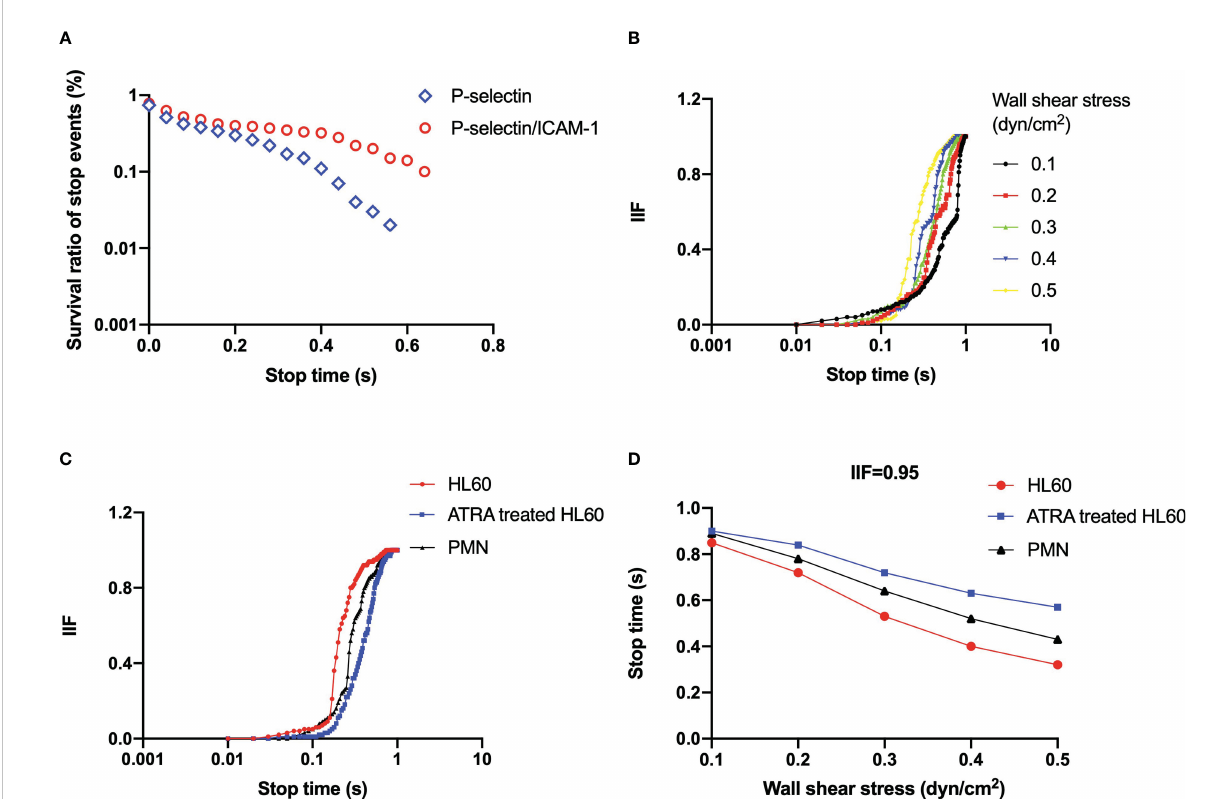
FIGURE 5 (A) Representative plot of the survival ratio of stop events versus stop time under wall shear stress of 0.3 dyne/cm 2 for all-trans retinoic acid (ATRA)- treated (1 × 10 -6 M, 120 h) HL60 cells on P-selectin (blue) alone or combined with ICAM-1 (red). (B) Plots of integrin-involved fraction (IIF) of stop events against stop time for ATRA-treated (1 × 10 -6 M, 120 h) HL60 cells on P-selectin with ICAM-1 under wall shear stresses of 0.1 dyne/cm 2 (black), 0.2 dyne/cm 2 (red), 0.3 dyne/cm 2 (green), 0.4 dyne/cm 2 (blue), and 0.5 dyne/cm 2 (yellow). (C) IIF plot against stop time at wall shear stress of 0.3 dyne/cm 2 , and (D) variation of the stop time, at which IIF took its value of 0.95, versus wall shear stress for neutrophils (black), wild HL60 cells (red), and ATRA-treated (1 × 10 -6 M, 120 h) HL60 cells (blue) on P-selectin with ICAM-1. The data came from at least 100 events in